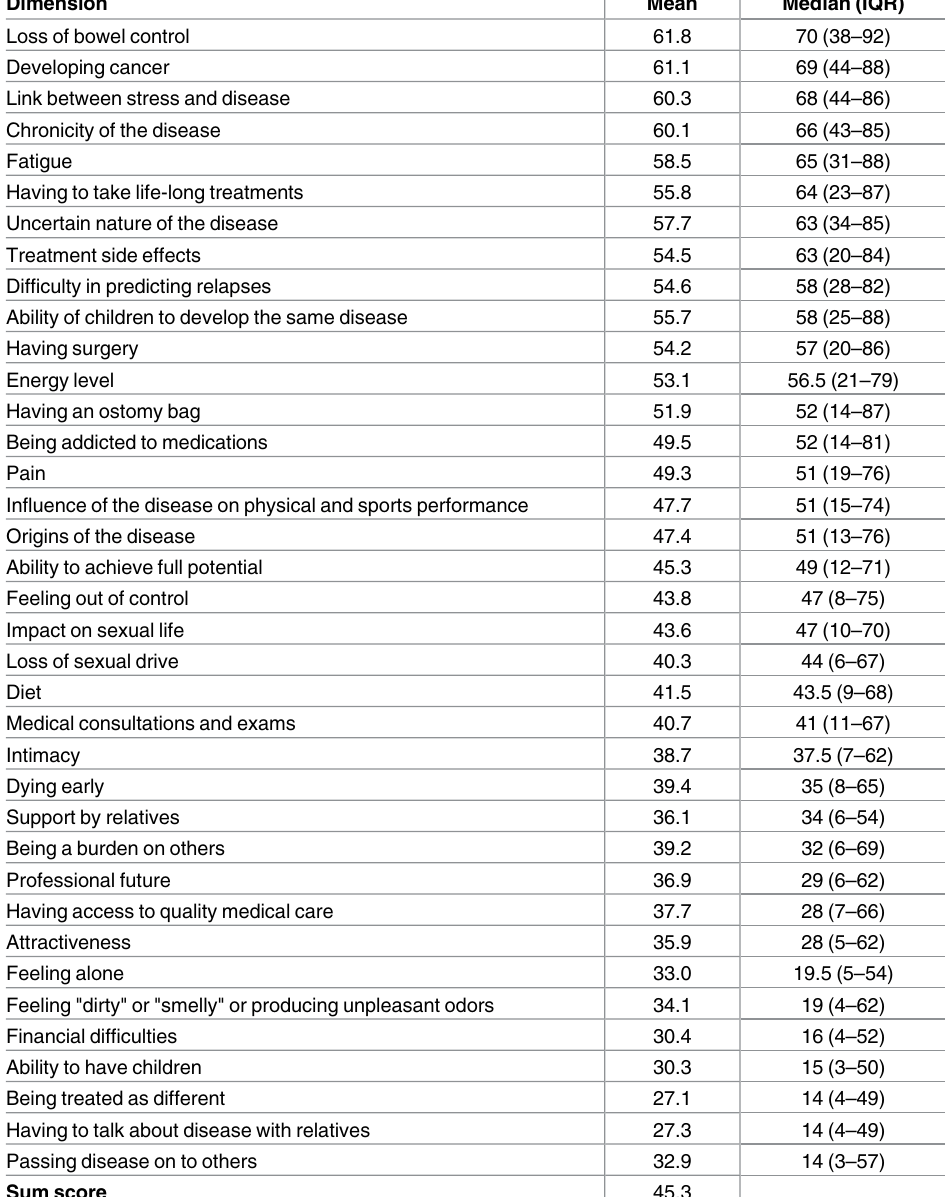
Table 2. Mean, median, and interquartile range (IQR) scores for each concern according to gender, type of diagnosis, language, and age.